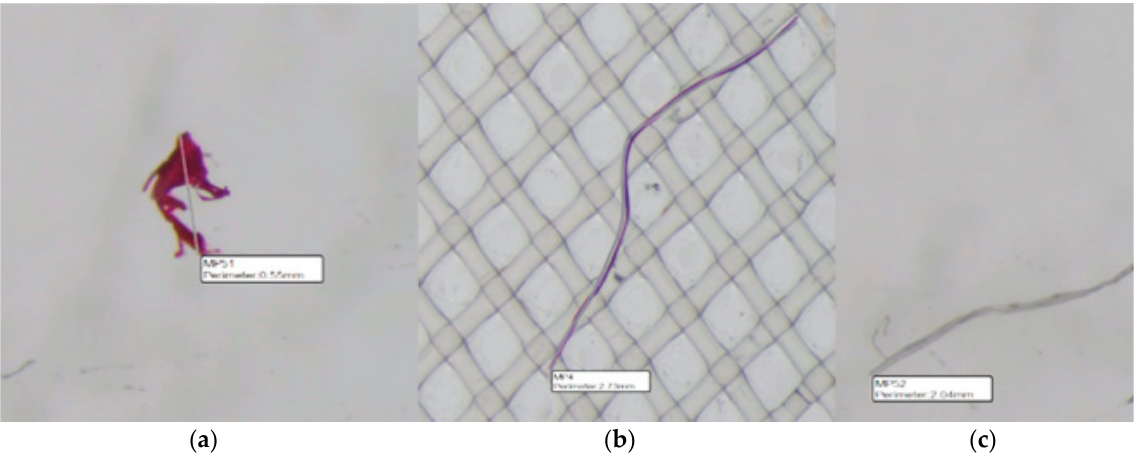
Figure 3. Particles after staining with rose bengal ( a ), partially dyed semi-synthetic fibre ( b ), and synthetic fibre ( c ).